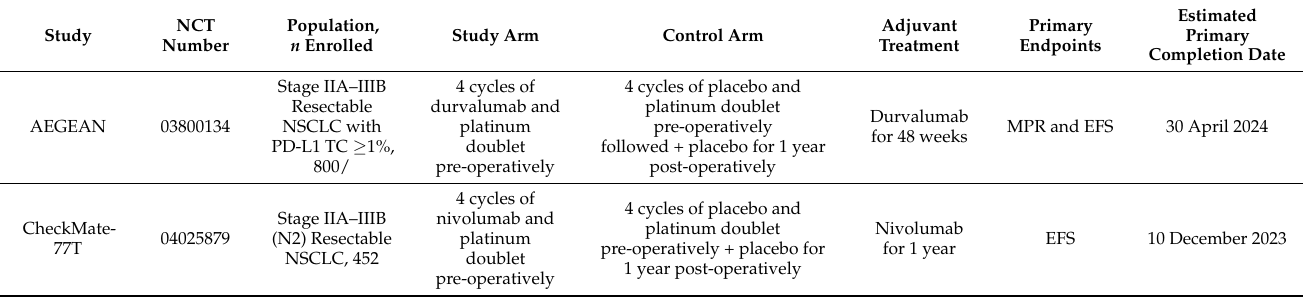
Table 5. Summary of Upcoming Randomized Phase III Neoadjuvant Chemoimmunotherapy